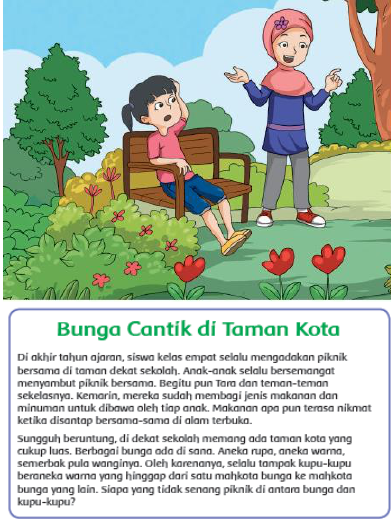
Figure 11: The story “Beautiful flower in the town garden”